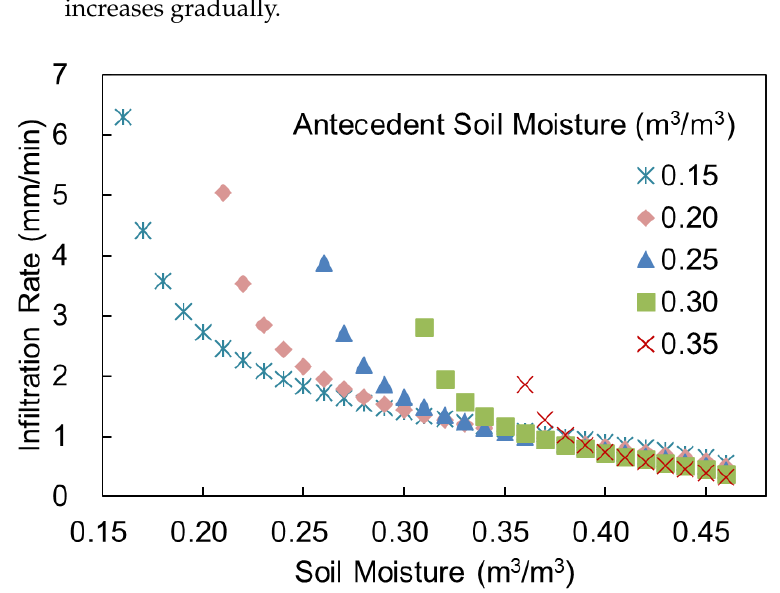
Figure 8. Curves of infiltration rate–soil moisture content for different initial soil moisture conditions.